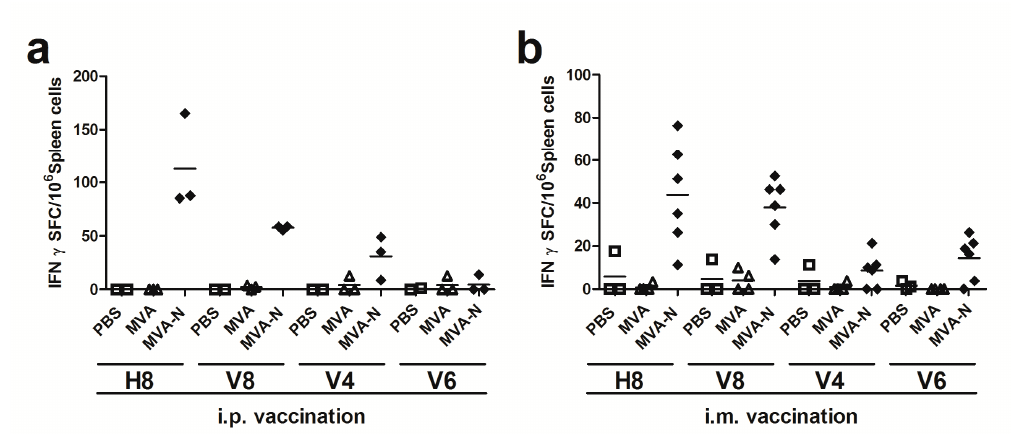
Figure 3. Screening for H2-d restricted T cell epitopes in MERS-CoV N protein using matrix peptide pools; ( a–b ) groups of BALB/c mice ( n = 2 to 6) were vaccinated twice (21-day interval) by i.p. ( a ) or i.m. ( b ) application with 10 8 plaque-forming-units (PFU) of recombinant MVA-MERS-N (MVA-N). Mice inoculated with non-recombinant MVA (MVA) or phosphate-buffered saline (PBS) were used as controls. Splenocytes were restimulated in vitro with pools of overlapping peptides corresponding to MERS-CoV N protein. IFN- γ spot-forming CD8+ T cells (IFN- γ SFC) were measured by ELISPOT. The lines represent means.